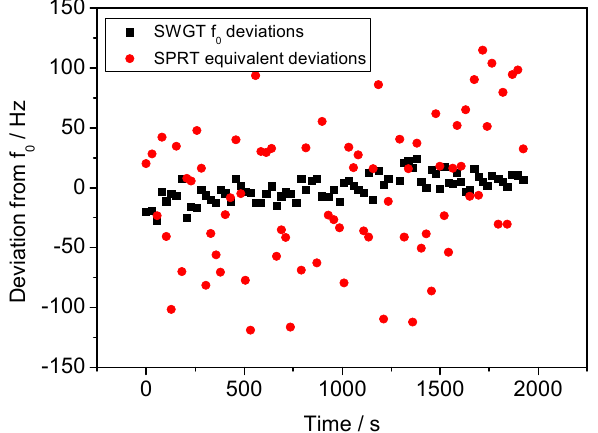
Figure 14. Comparison between the measurement stability of SWGT (black squares) and SPRT (red circles). In this plot the SPRT resistance deviations have been converted into equivalent frequency deviations. The SWGT measurement stability is about five times better than the SPRT.